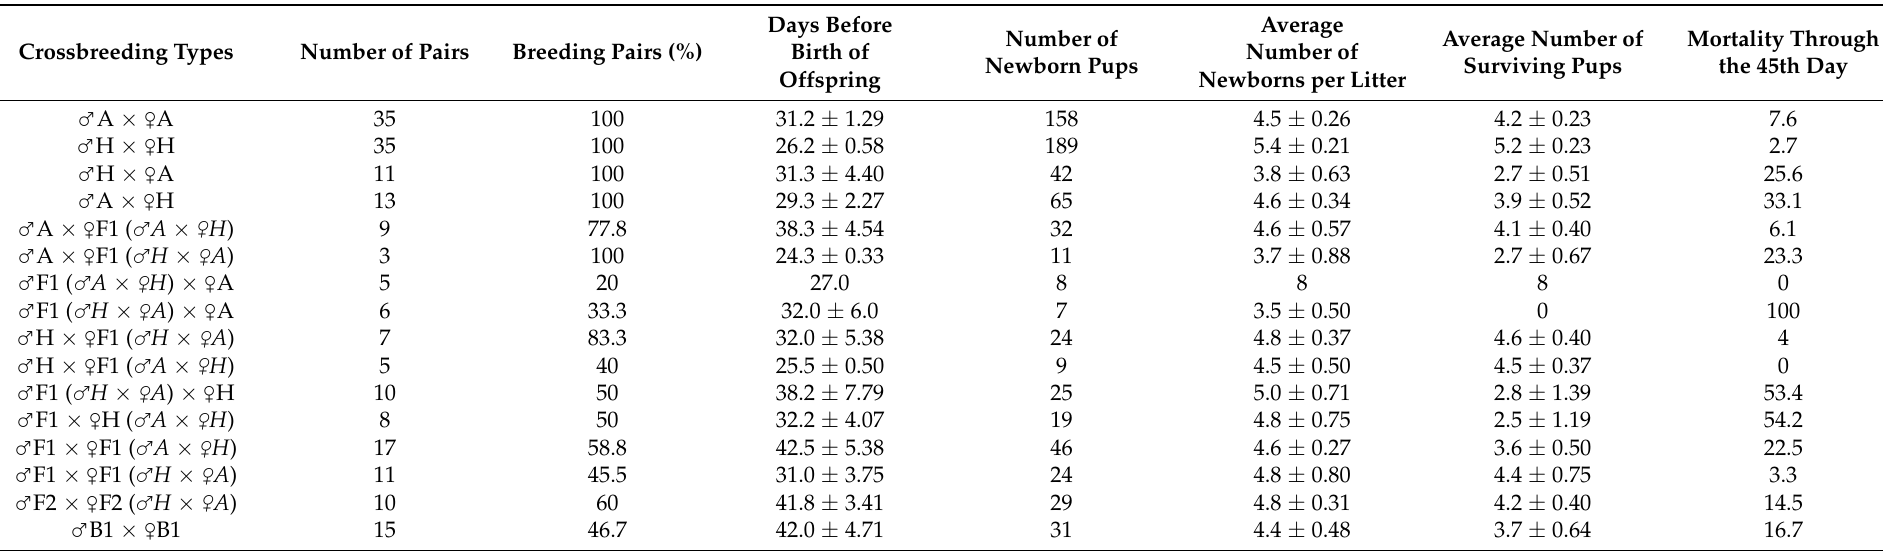
Table 5. The results of crossing of intraspecific forms of M. hartingi and their F1 and F2 hybrids (A: M. h. ankaraensis , H: M. hartingi from the Eastern